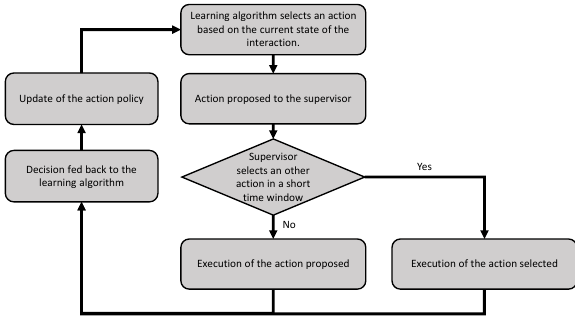
Figure 13: High-level action selection and learning flow used in